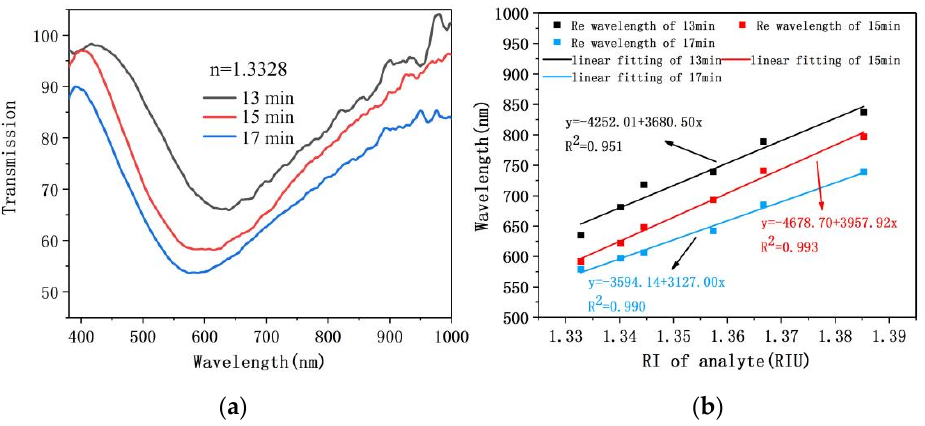
Figure 11. ( a ) Transmission spectrum of fiber/Ag-Cu films sensor at a refractive index of 1.3328 under different bronze mirror reaction time (in minutes); ( b ) Sensitivity fitting curve of fiber/Ag-Cu films sensor under different bronze mirror reaction time (in